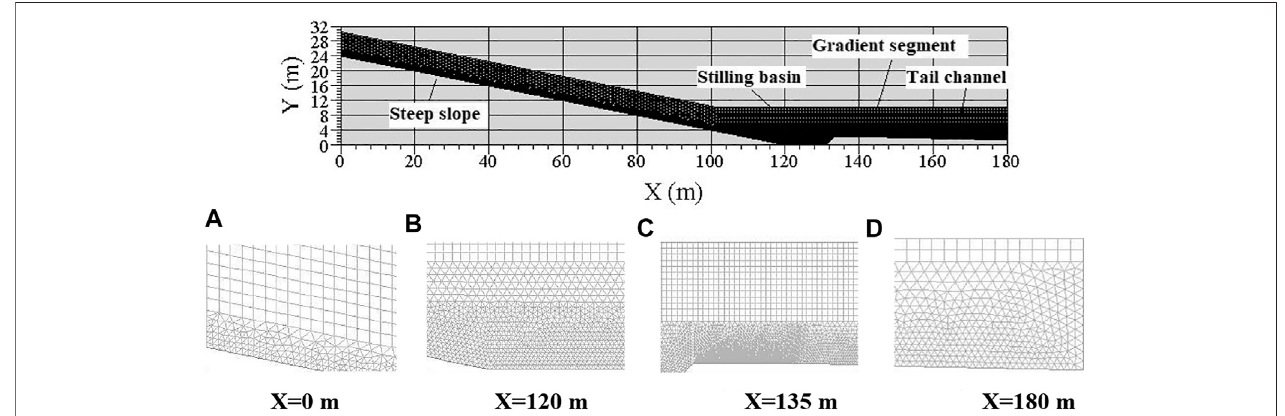
FIGURE 3 | Schematic diagram of the geometric model and mesh generation (A – D) in different locations.